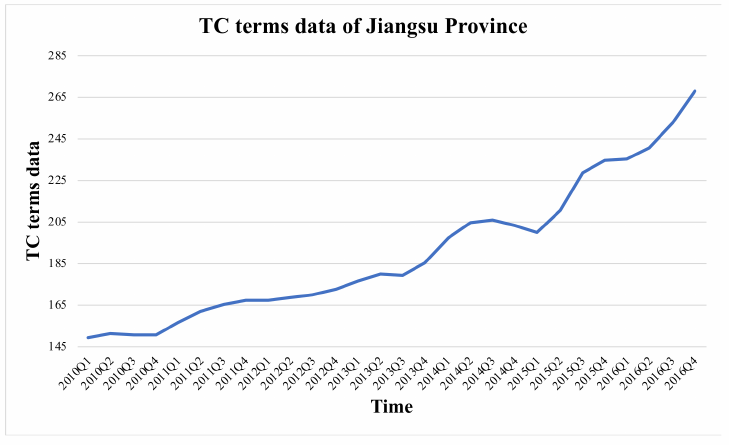
Figure 8. TC terms data of Jiangsu Province.